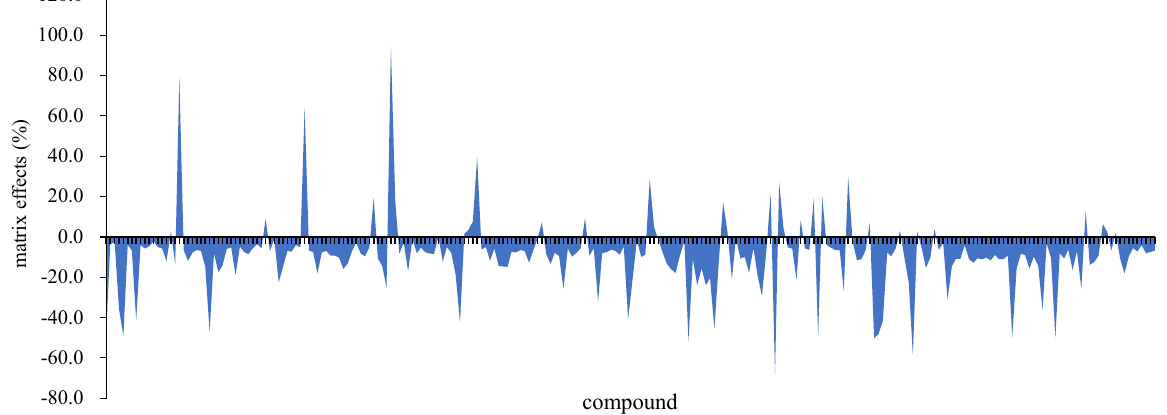
Figure 4. Matrix effects of 244 chemical contaminants in egg.